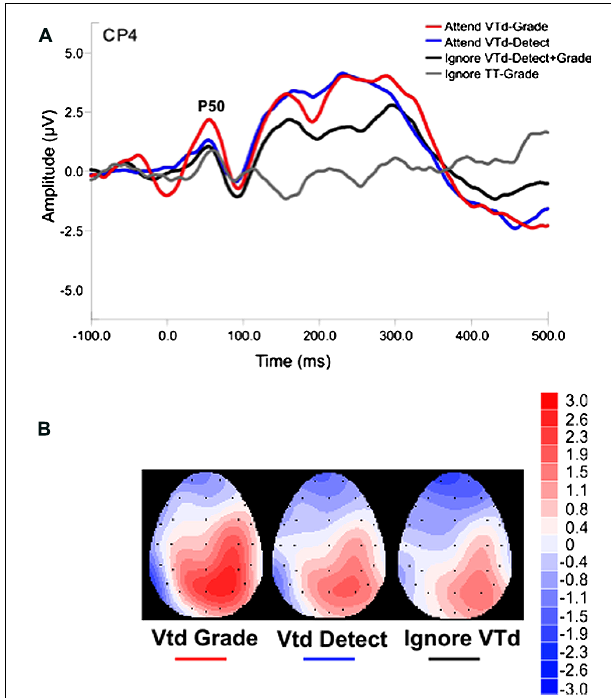
FIGURE 6 | (A) Grand average waveforms for the crossmodalVTd conditions in Experiment 2 at CP4.The P50 ERP component is labeled on the trace for electrode site CP4. Blue, red, and black traces showVTd stimuli in the detect, grade or when attention was directed to the unimodal stimuli (IgnoreVTd), respectively.The gray trace shows the ERP time-locked to theTT stimuli when participants were responding to the crossmodal stimuli in the Grade response condition (IgnoreTT-Grade). (B) ScalpTopography Maps of the P50 Component: Inset shows modulation of the P50 ERP waveforms in response to conditions in A. Images show group averaged data of peak areas of cortical activity generated over a 30 ms time window (40–70 ms) centered around the P50 ERP peak. All values are in microvolts ( μ